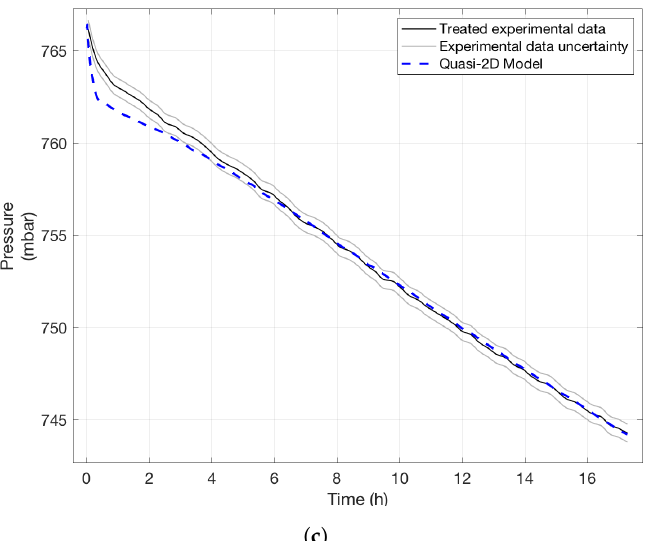
Figure 7. Comparison between the experimental and simulated curves for the pressure decrease in the VST UC during the deuterium experiments, for three different temperatures. Propagated uncertainty for experimental data is displayed with two extra curves (in gray ) to increase visibility. Simulated curves use dissolution parameters determined by the curve-matching strategy ( vide Table 2). Increased data fluctuation seen in ( a ) results from: the graph scale (due to a smaller total pressure variation during the experiment), and a larger set of collected experimental points. ( a ) Experiment and simulation for heater set at 100 ◦ C. ( b ) Experiment and simulation for heater set at 350 ◦ C. ( c ) Experiment and simulation for heater set at 400 ◦ C.